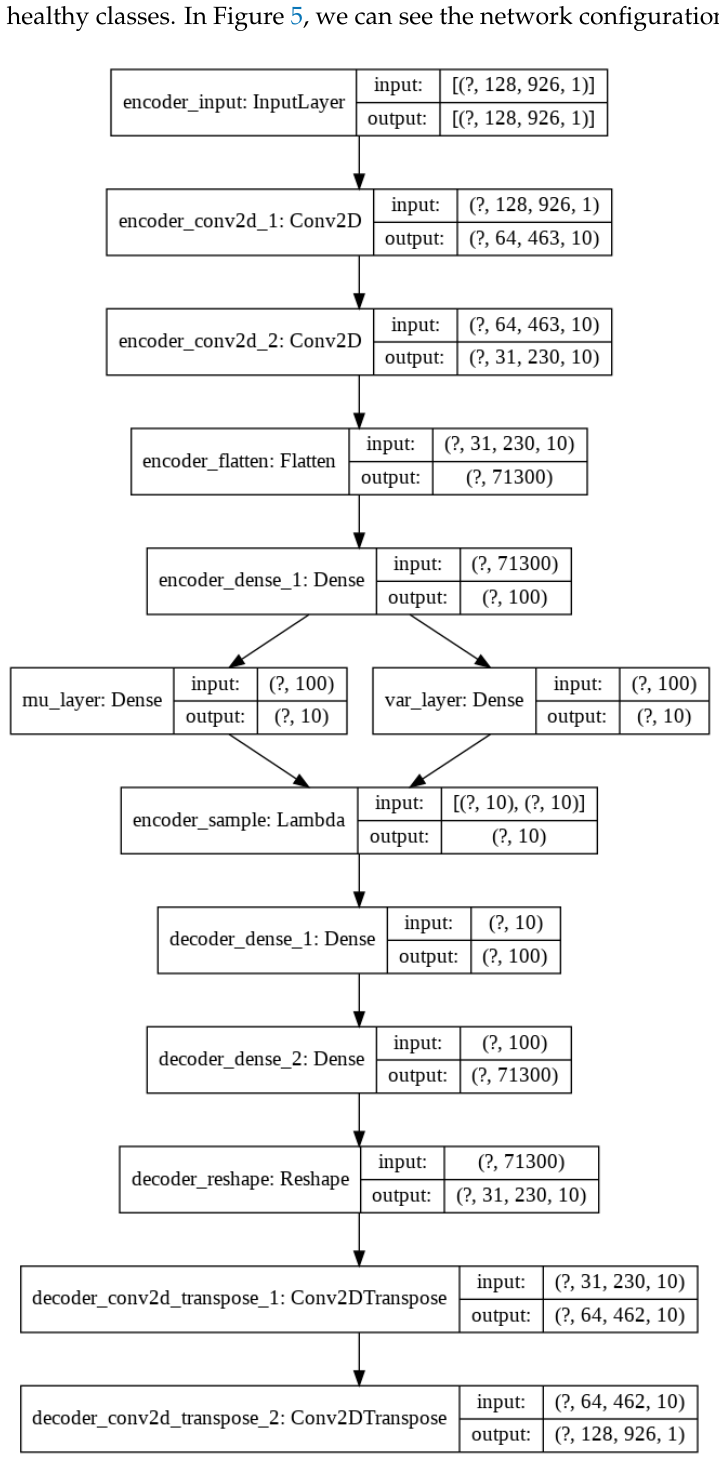
Figure 5. VAE scheme configuration for data